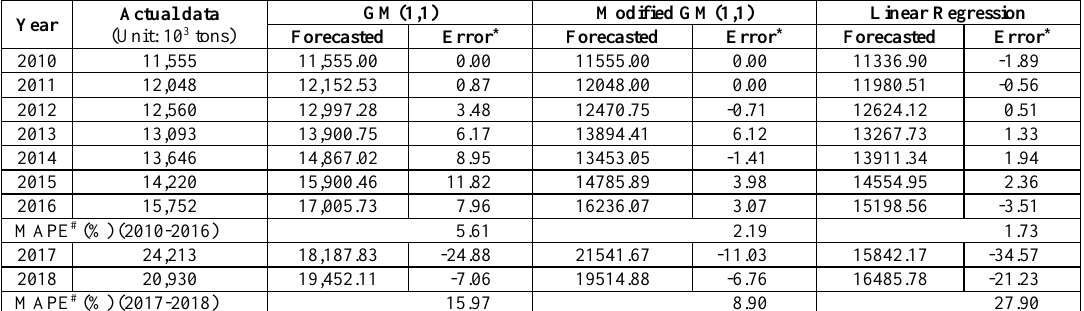
Table 4. Comparison of forecasted values and performance measurement of different